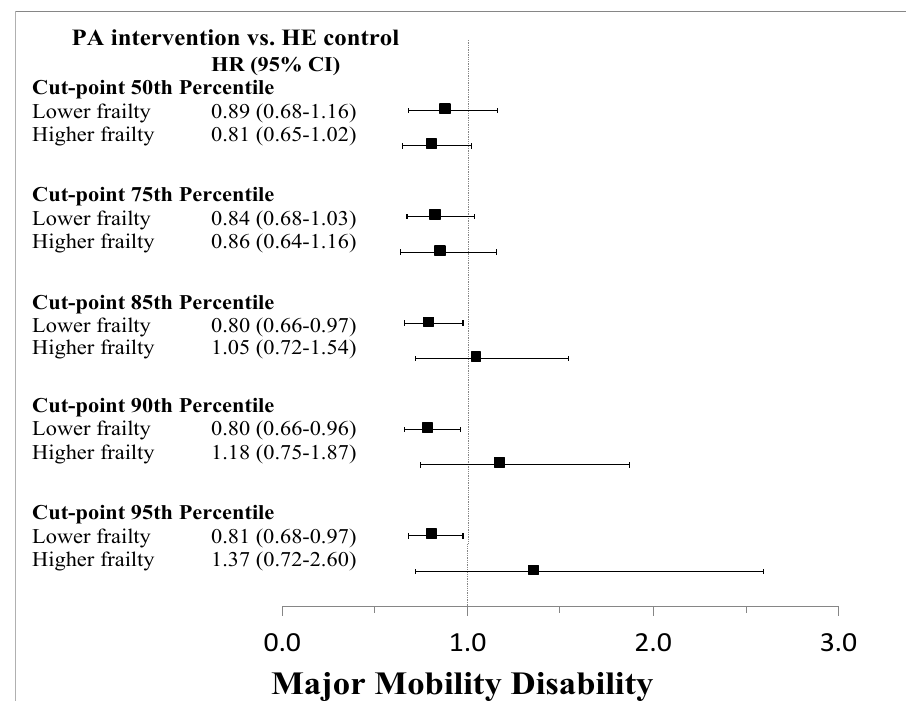
Figure 6. Cox proportional hazards regression results testing frailty index cut ‐ points as strata to identify subgroups in which the intervention was no longer effective in preventing major mobility disability.